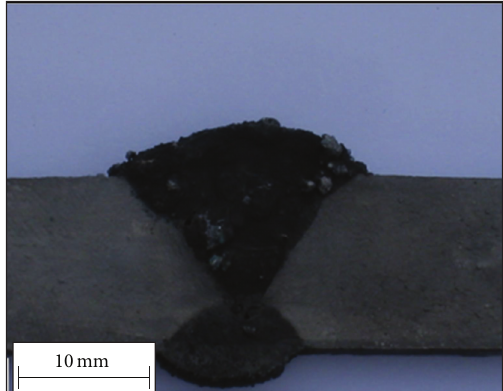
Figure 4: Optical image of oxidized AA6061 welded sample consist- ing of parent and fusion metal for 40 hours at 600 ∘